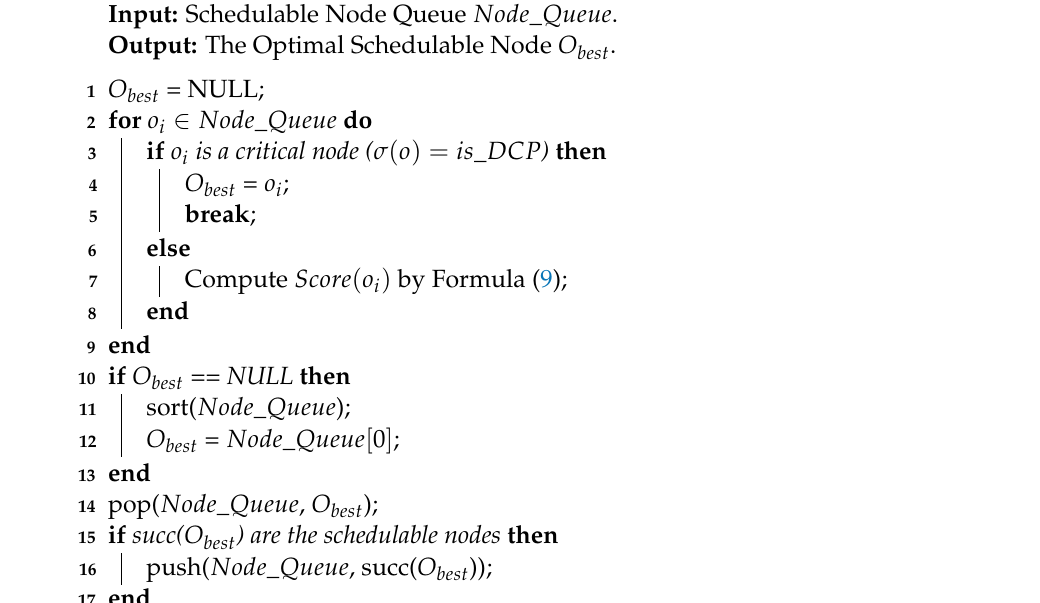
Algorithm 1: The algorithm for finding the optimal schedulable